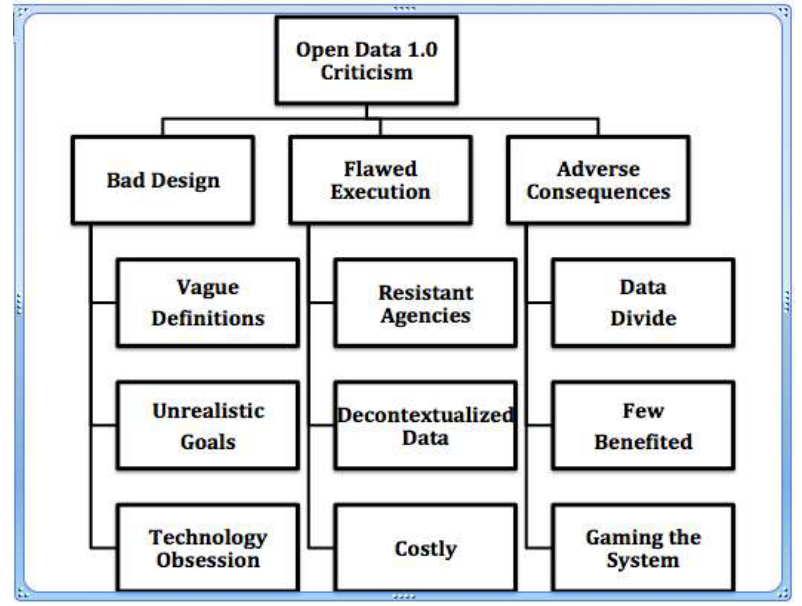
Figure 1: Open Data 1.0